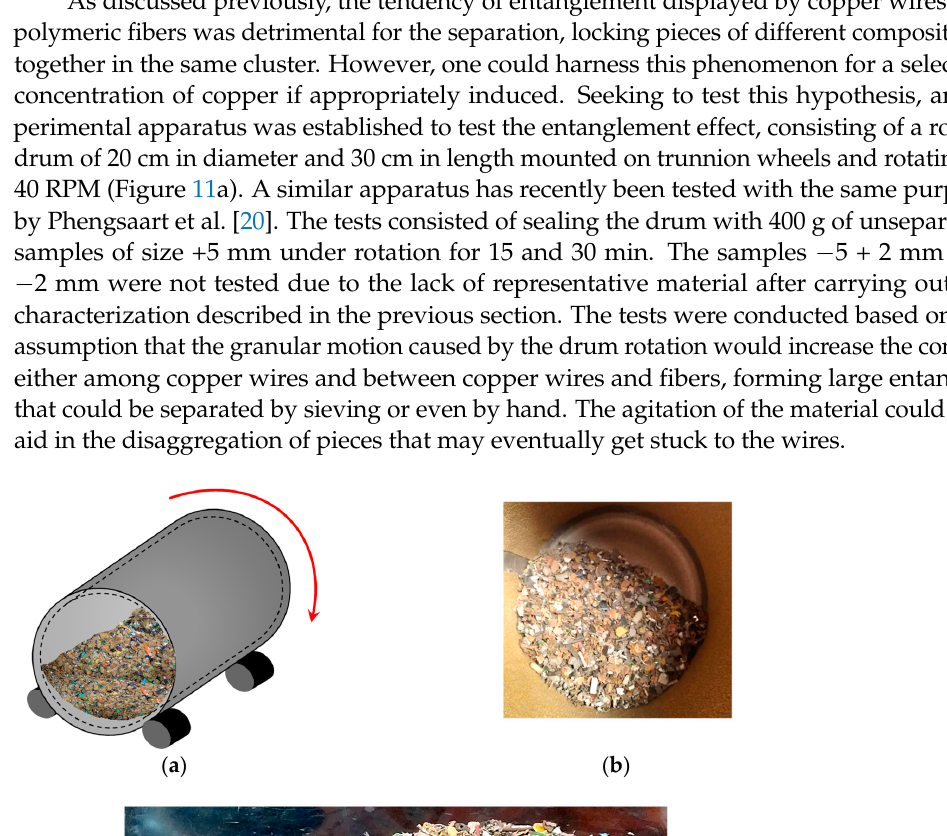
Table 3. Drumming tests results in terms of yield and recovery of copper tangles.